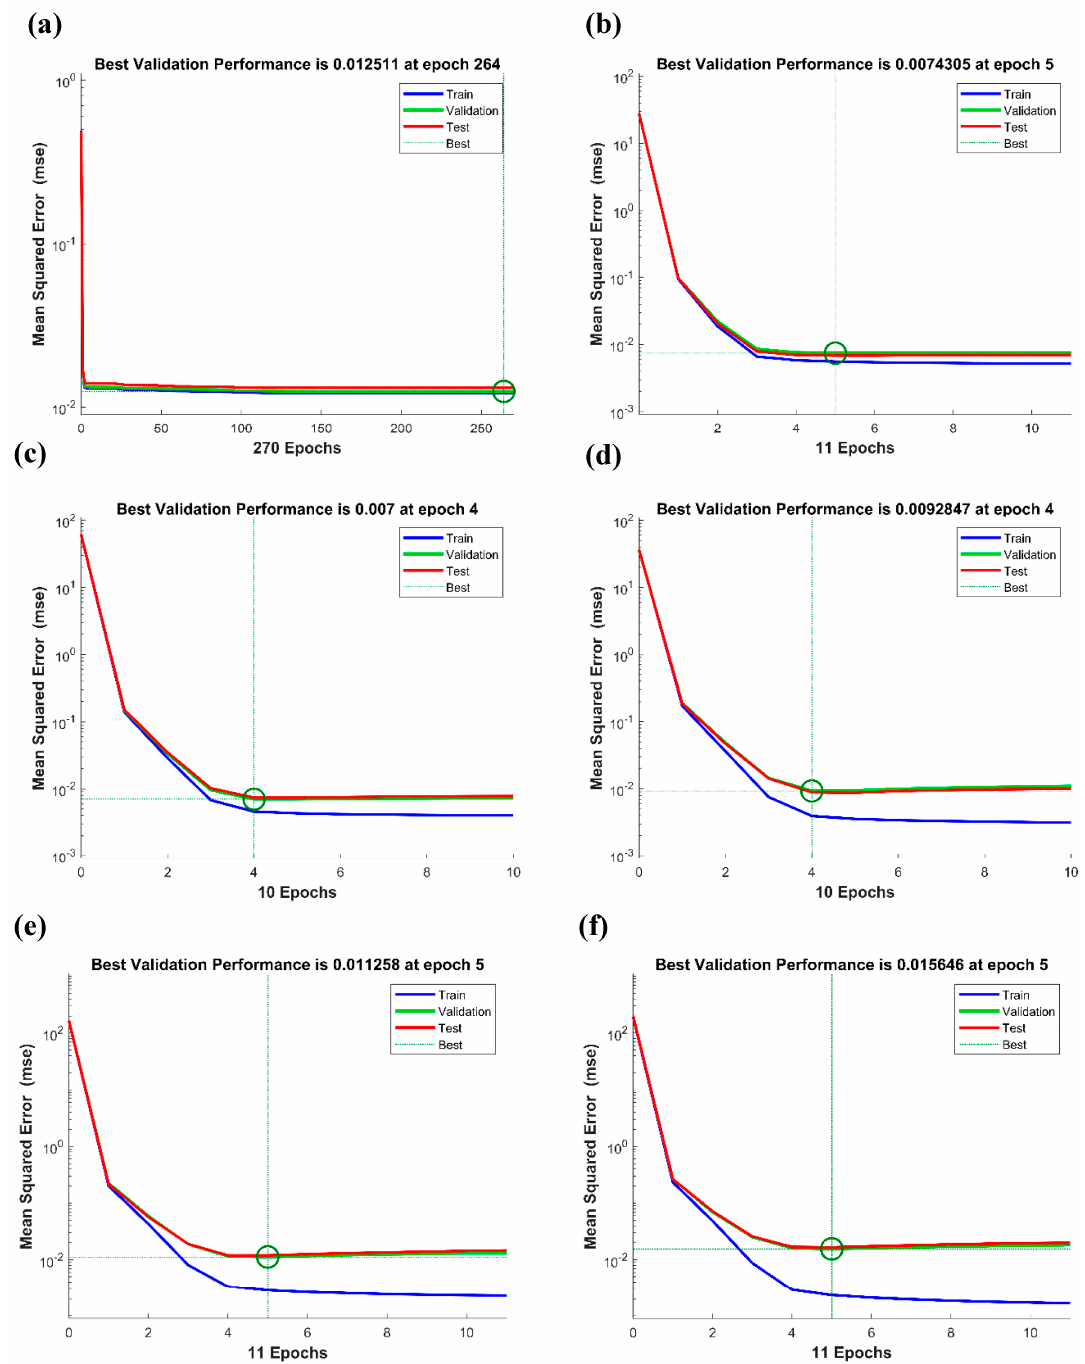
Figure 2. Mean squared error with increasing number of epochs for ( a ) 10 hidden units, ( b ) 500 hidden units, ( c ) 1000 hidden units, ( d ) 1500 hidden units, ( e ) 2000 hidden units, and ( f ) 2500 hidden